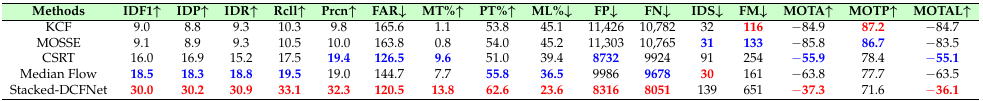
Table 5. Results of KCF, MOSSE, CSRT, Median Flow, and Stacked-DCFNet on the KIT AIS pedestrian dataset. The first and second best values are highlighted. Methods